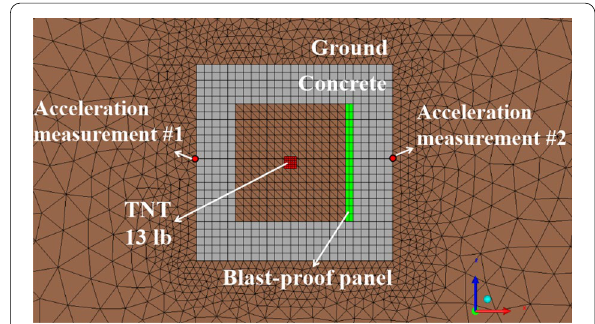
Fig. 8 Point of acceleration measurement and simulation conditions.